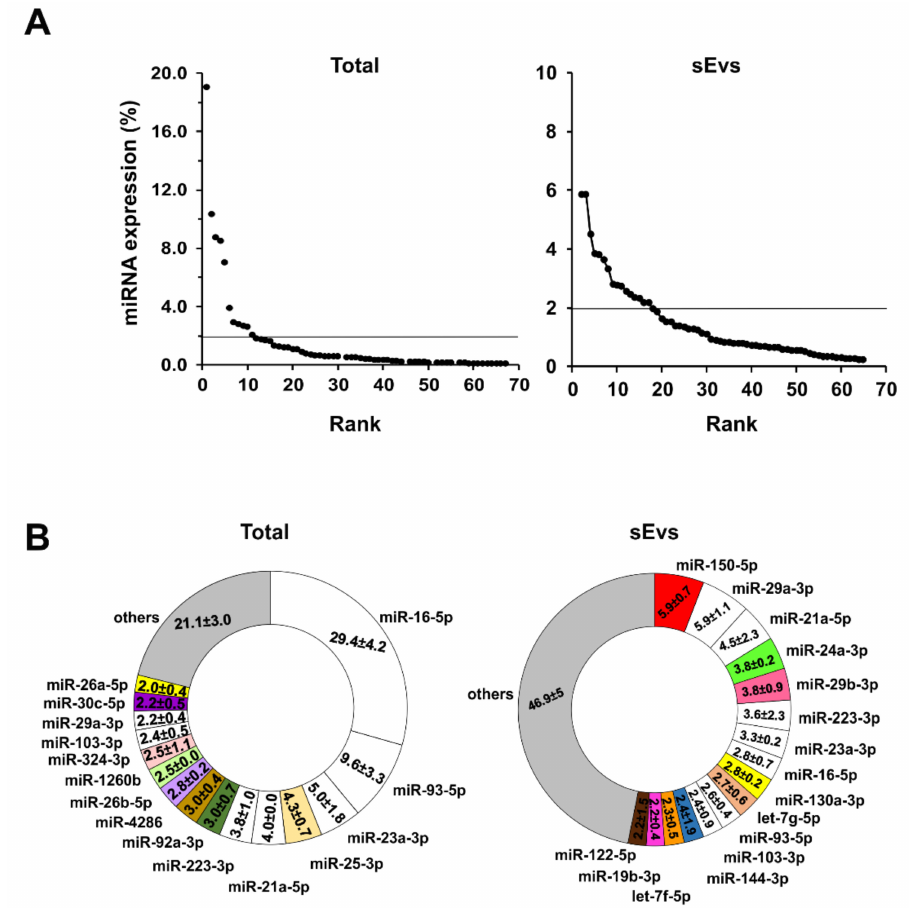
Figure 6. Conserved miRNA abundance analysis in the mouse plasma. ( A ) Rank abundance curve of the conserved miRNAs both expressed in the mouse total plasma (left panel) and enriched in the sEVs (right panel). The threshold was set at 2% of the miRNA expression (horizontal line). ( B ) The most abundant conserved miRNAs are shown in the ring graph in both total plasma (left panel) and sEV (right panel) compartments. The number reported in each slice of the ring represents the percentage of expression of the indicated